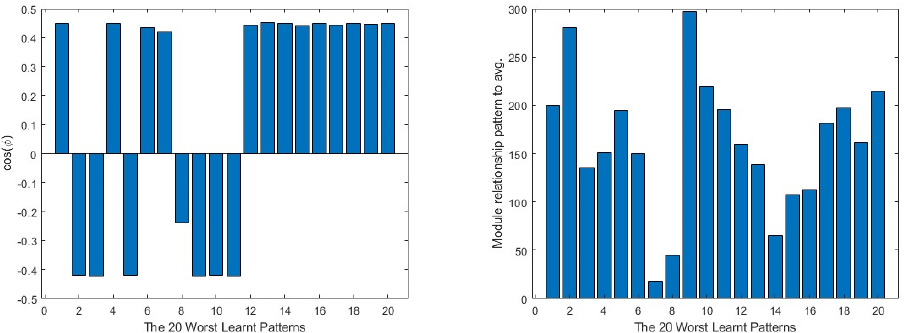
(cid:3339) (cid:3339) (cid:12) (cid:12) (cid:4698) relationship to the av- (cid:4698) relationship to the av- (cid:3339) ∂ Loss µ (cid:12) (cid:12) (cid:4698) relationship to the av- (cid:3105)(cid:3024) (cid:3289) (cid:3105)(cid:3024) (cid:3289) (cid:12) (cid:12) relationship to the ∂ W n (cid:3105)(cid:3024) (cid:3289)